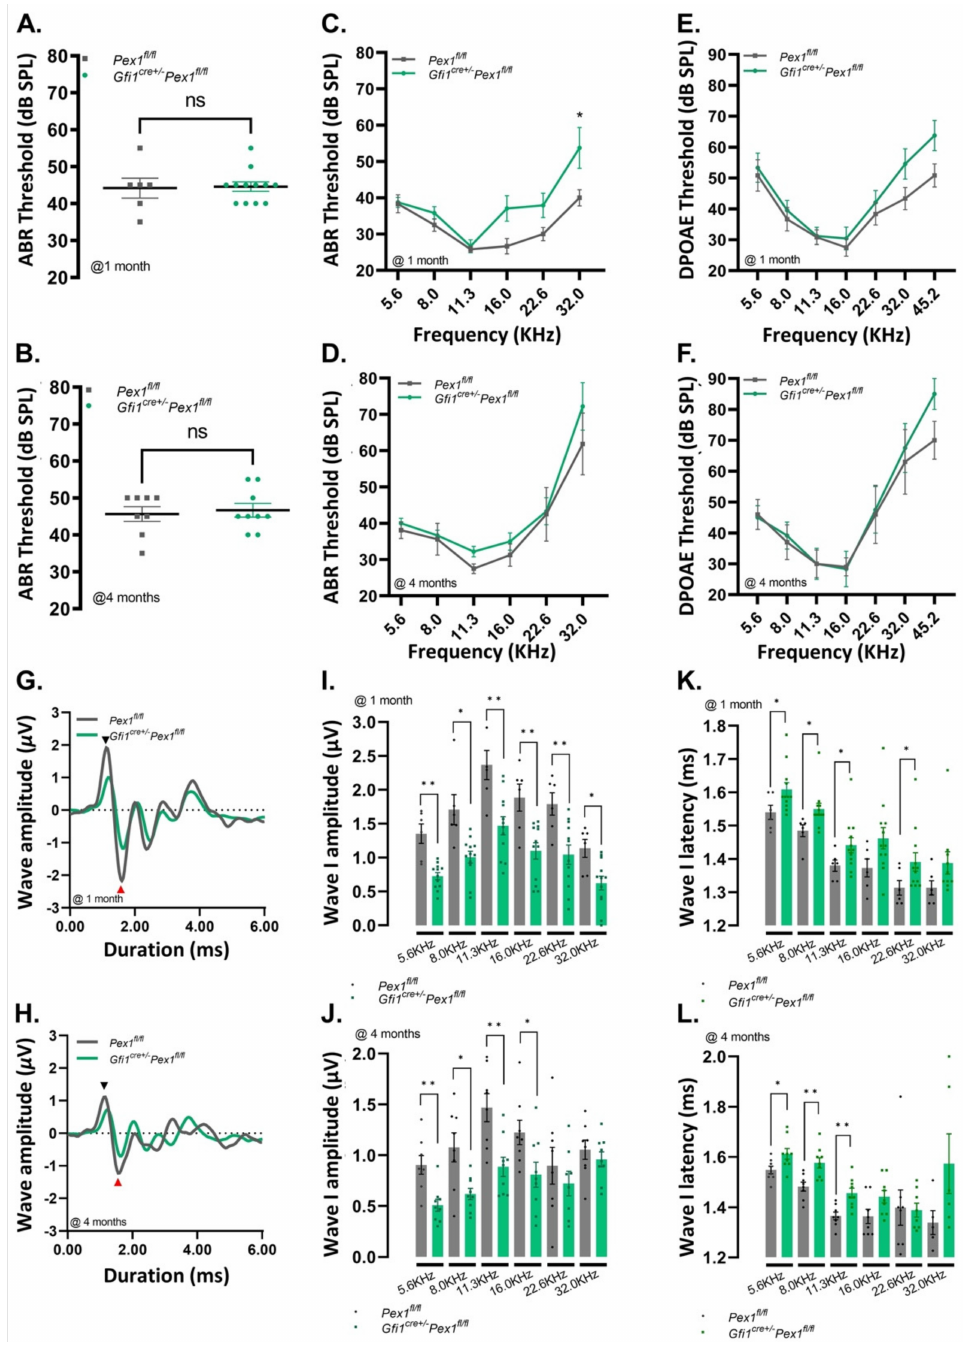
Figure 2. Decrease of the wave I ABR amplitude is observed in Gfi1 cre/+ Pex1 fl/fl mice. ( A , B ) Click ABR recordings on Pex1 fl/fl (grey) and Gfi1 cre/+ Pex1 fl/fl (green) mice at 1 month (Table S1; mean ± S.E.M. ns p = 0.9334, Mann–Whitney test) ( A ) and 4 months (Table S1; mean ± S.E.M. ns p = 0.9638, Mann–Whitney test) ( B ); ( C , D ) Pure-tone ABR recordings as a function of frequencies (kHz) on Pex1 fl/fl (grey) and Gfi1 cre/+ Pex1 fl/fl (green) mice at 1 month (Table S1; mean ± S.E.M. 5.6 kHz: ns p > 0.999, 8.0 kHz: ns p > 0.999, 11.3 kHz: ns p > 0.999, 16.0 kHz: ns p = 0.213, 22.6 kHz: ns p = 0.631, 32.0 kHz: * p = 0.033—2way ANOVA Bonferroni’s multi-comparison test) ( C ) and 4 months (Table S1; mean ± S.E.M. 5.6kHz: ns p > 0.999, 8.0 kHz: ns p > 0.999, 11.3 kHz: ns p > 0.999, 16.0 kHz: ns p > 0.999, 22.6 kHz: ns p > 0.999, 32.0 kHz: ns P = 0.551—2way ANOVA Bonferroni’s multi-comparison test) ( D ); ( E , F ) Distortion-product otoacoustic emissions (DPOAEs) recordings as a function of frequencies (kHz) on Pex1 fl/fl (grey) and Gfi1 cre/+ Pex1 fl/fl (green) mice at 1 month (Table S2; mean ± S.E.M. 5.6